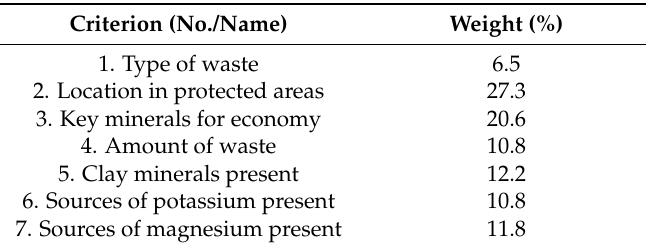
Table 2. Weights of criteria.